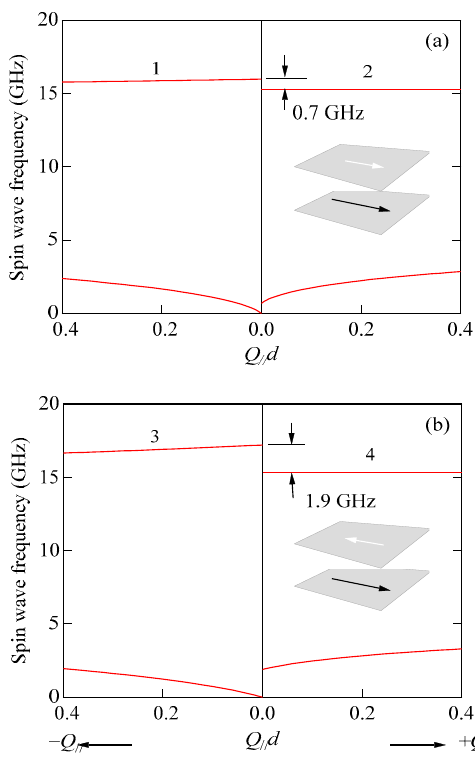
Figure 24. The solid lines are calculated SW frequencies in the (M1/spacer/M2) trilayer at zero magnetic field as a function of Q // d in which d is the spacer thickness. ( a ) Parallel arrangement and ( b ) anti-parallel arrangement. The magnetic and layer parameters used in the calculations are given in the text.